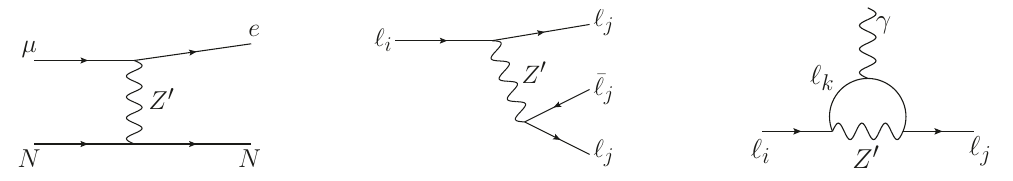
e conversion. ! ‘ j (cid:13) . !